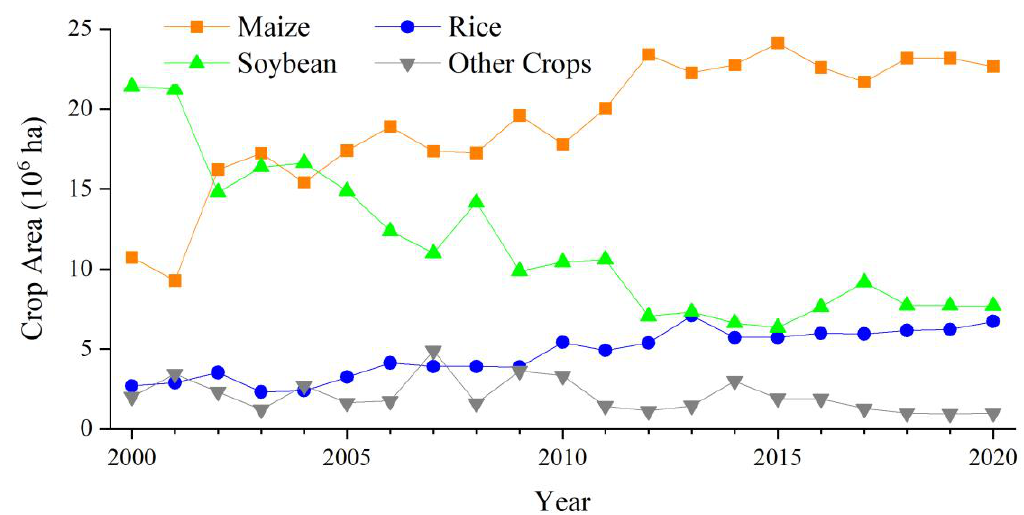
Figure 7. Annual crop area changes in the NEC from 2000 to 2020.